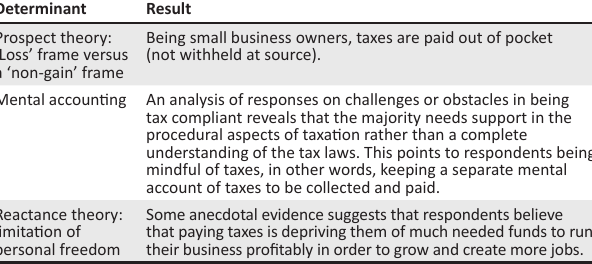
TABLE 4: Results of the analysis for the population surveyed using the factor ‘Decision frames’.